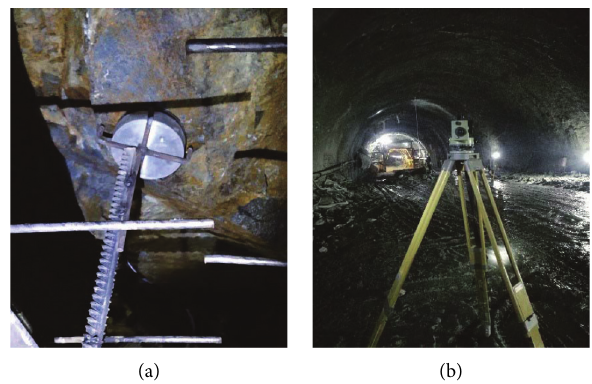
Figure 6: On-site measurement. (a) Installation of the pressure cell. (b) Deformation monitoring of the